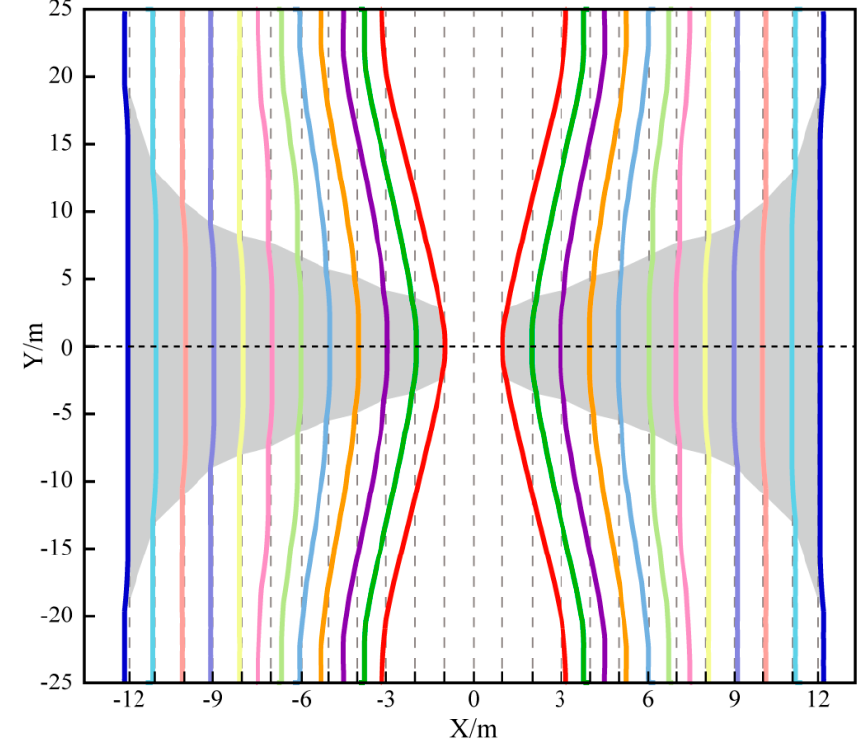
Figure 6. Fracture propagation paths with different perforation spacing. Different colors represent different perforation spacing. Due to the isotropic model, fractures corresponding to the two perforations are symmetrically distributed. When hydraulic fractures propagate to the boundary of the grey shadow zone, the stress shadow effect is the strongest.